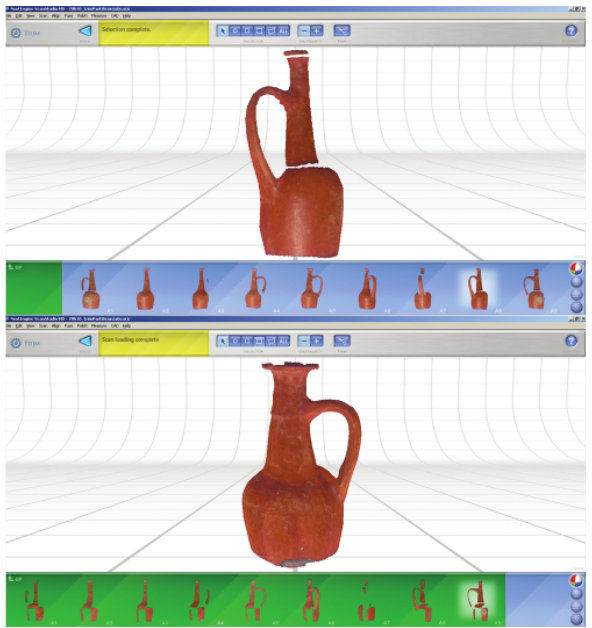
Figure 13. Above, single textured scans with re fl ections; below, after trimming action to remove them (and